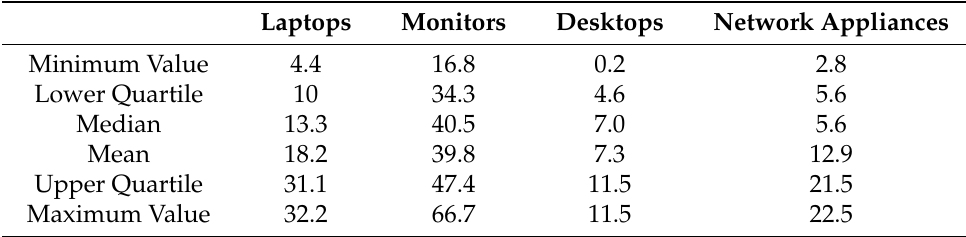
Table 3. Appliances’ converter power level distribution (% of rated